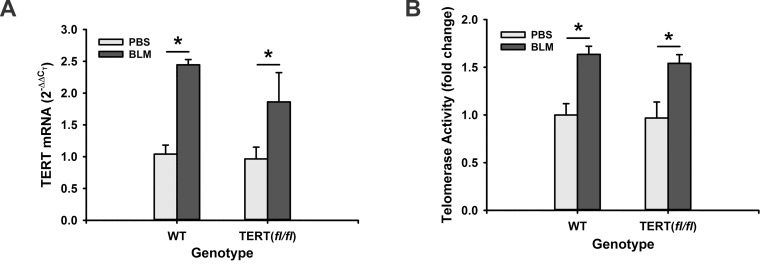
TERT and telomerase in floxed TERT vs WT mice.Total RNA or protein lysates were prepared from the lung tissues and MLF from BLM or PBS-injected TERT fl/fl or WT mice. TERT gene expression was analyzed by qRT-PCR and expressed as 2-ΔΔCT (n = 3) in (A), and the telomerase activities were detected by TRAP-ELISA kit and expressed as fold change over their PBS control, respectively (B). n = 3. *, P < 0.05.